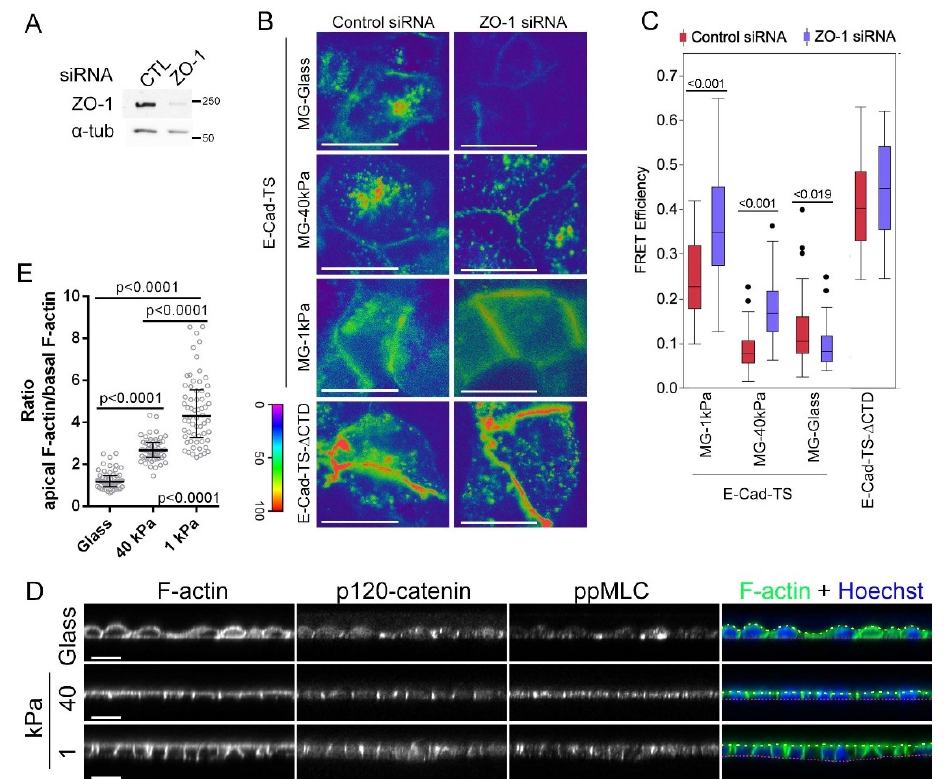
Figure 4. ECM stiffness guides ZO-1 ′ s function in regulation of AJ tension. ( A ) Immunoblots confirming ZO-1 depletion by transfection of siRNAs targeting ZO-1 but not by non-targeting (CTL) siRNAs. α -tubulin is shown as a loading control. ( B , C ) Cells transfected with siRNAs as in panel ( C ) were seeded on substrates of different stiffnesses coated with Matrigel (MG) before transfection with an E-cadherin tension sensor constructs with E-cad-TS or without the C-terminal cytoplasmic domain of E-cadherin. FRET analysis was performed by epifluorescence microscopy ( D ). Panel ( E ) shows FRET efficiencies at cell–cell contacts (n is the number of cells analysed for control and ZO-1 siRNAs: E-Cadherin-TS MG-Glass, 46 and 45; MG-40 kPa, 59 and 59; MG-1 kPa 40 kPa, 47 and 48; E-Cadherin-TS- Δ CTD, 28 and 29). ( D , E ) MDCK cells seeded on glass or hydrogels of 40 or 1 kPa stiffness were fixed and stained for F-actin, p120-catenin and ppMLC. Shown are confocal z-sections ( D ). The right-hand column shows overlays of F-actin in green with Hoechst in blue in which the apical side of the monolayers have been traced with yellow and the basolateral side with red dashed lines. Single cell ratios of apical over basal F-actin fluorescence intensities were calculated (( E ); data points represent values from individual cells). Magnification bars, ( A ), 20 μ m; ( D ), 10 μ m.